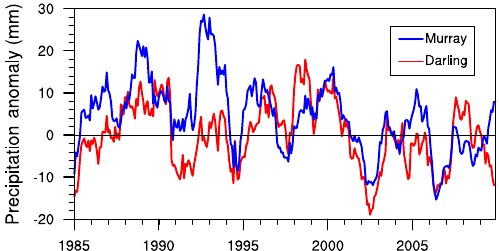
Figure 2. The 12-month smoothed precipitation anomaly for the Murray and Darling river